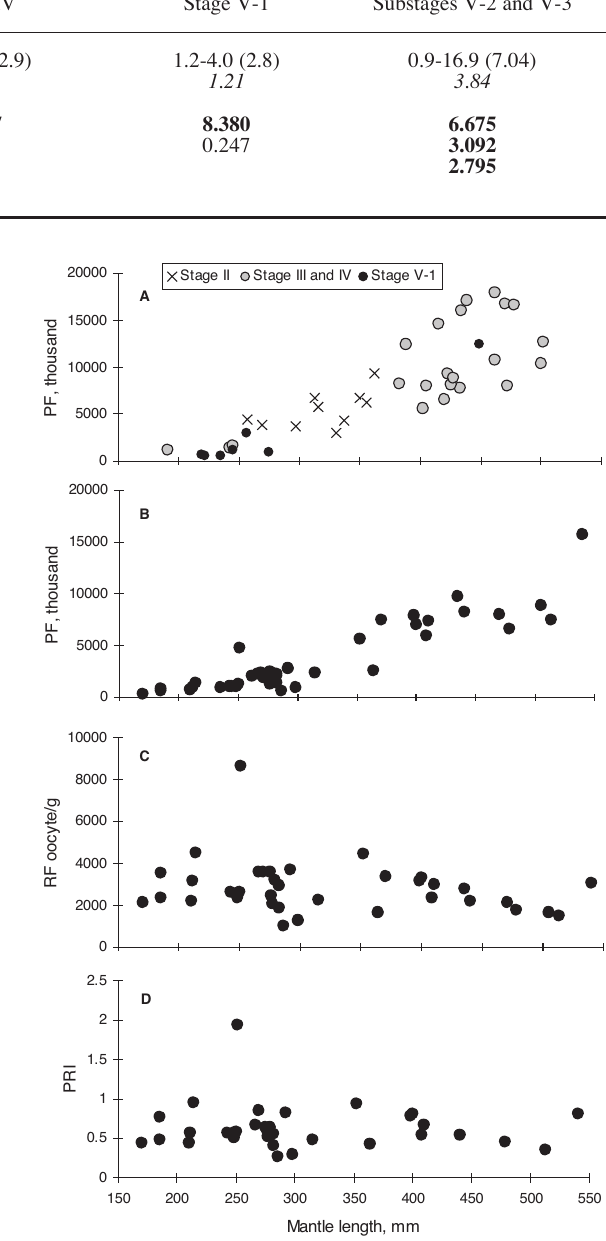
F IG . 6. – Potential fecundity in premature (A) and mature females (B), relative fecundity (C) and Index of Potential Reproductive Investment